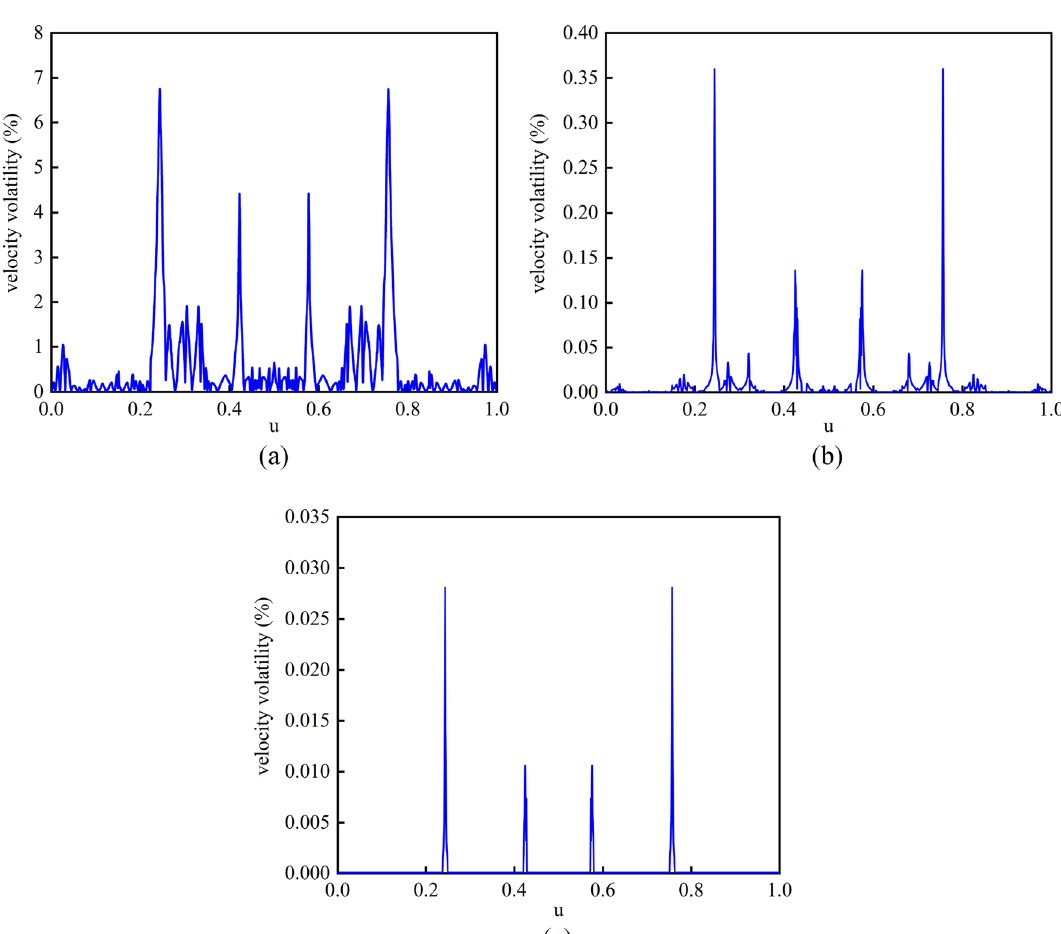
Figure 13. Feed velocity fluctuation of three interpolation algorithms (a) First-order Taylor expansion method, ( b ) Fourth-order Runge–Kutta method, (c) Parameter-corrected second-order Runge–Kutta